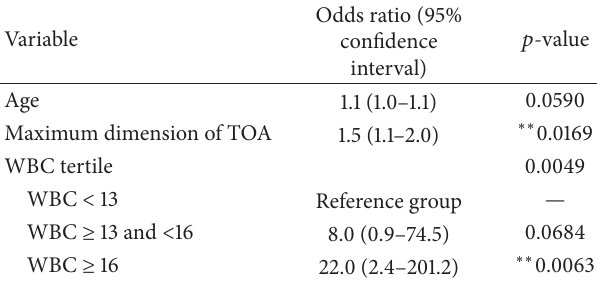
Table 3: Assessment of the likelihood of antibiotic treatment